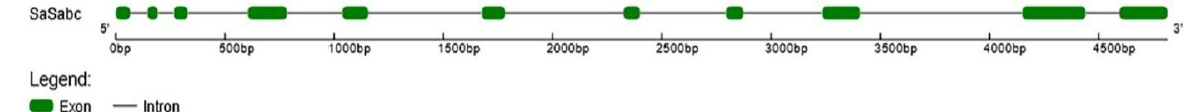
Figure 3. Structure of SaSabc gene.